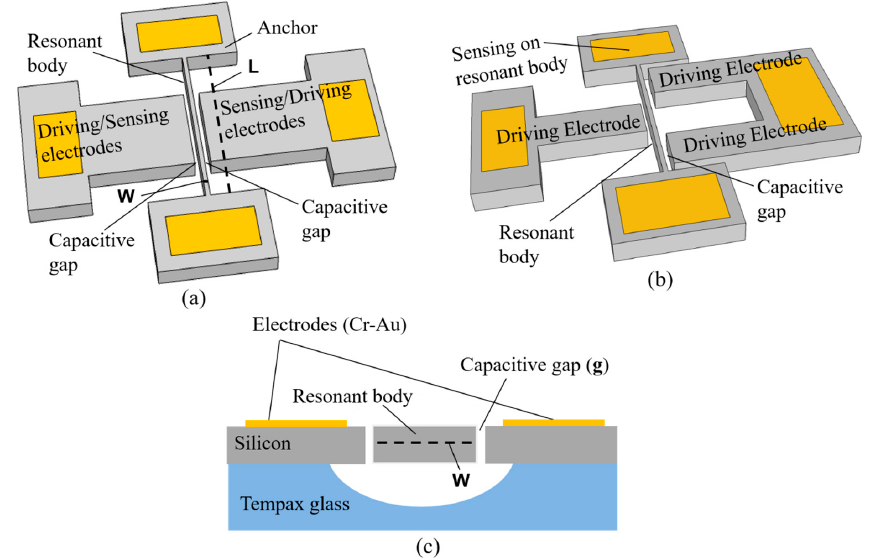
Figure 1. Fixed-fixed beam capacitive silicon resonators. ( a ) First mode vibration structure; ( b ) third mode vibration structure; ( c ) cross-sectional structure.